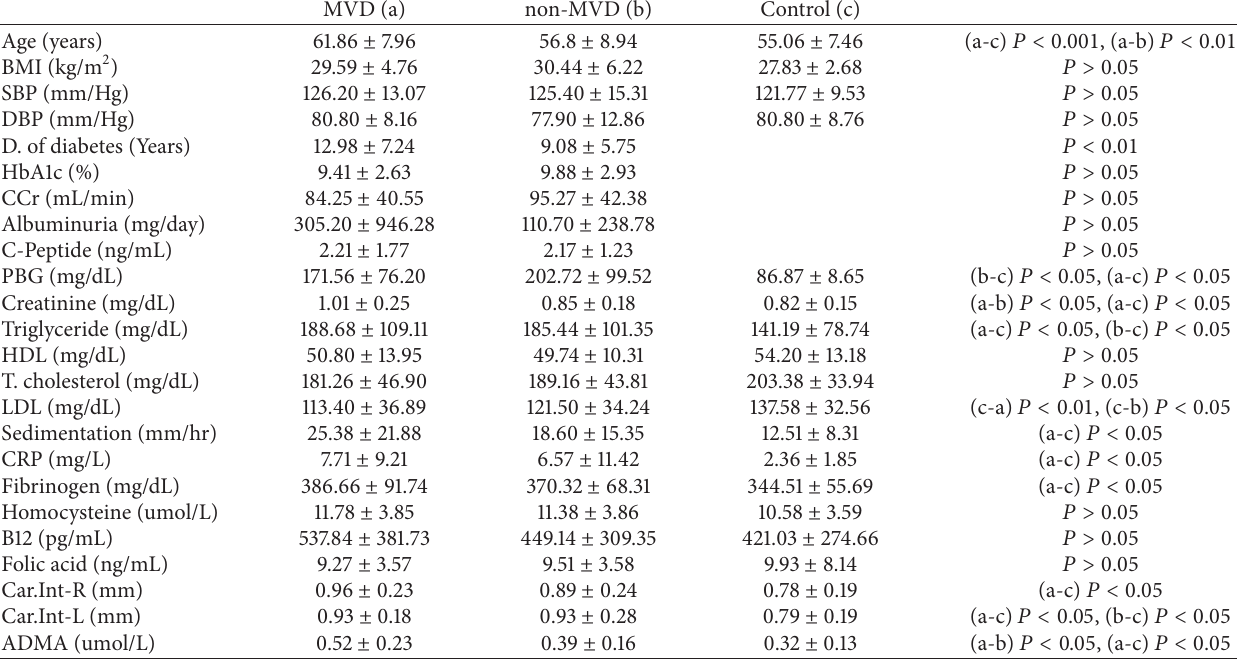
Table 1: Comparison of the common parameters in MVD, non-MVD, and the control group.